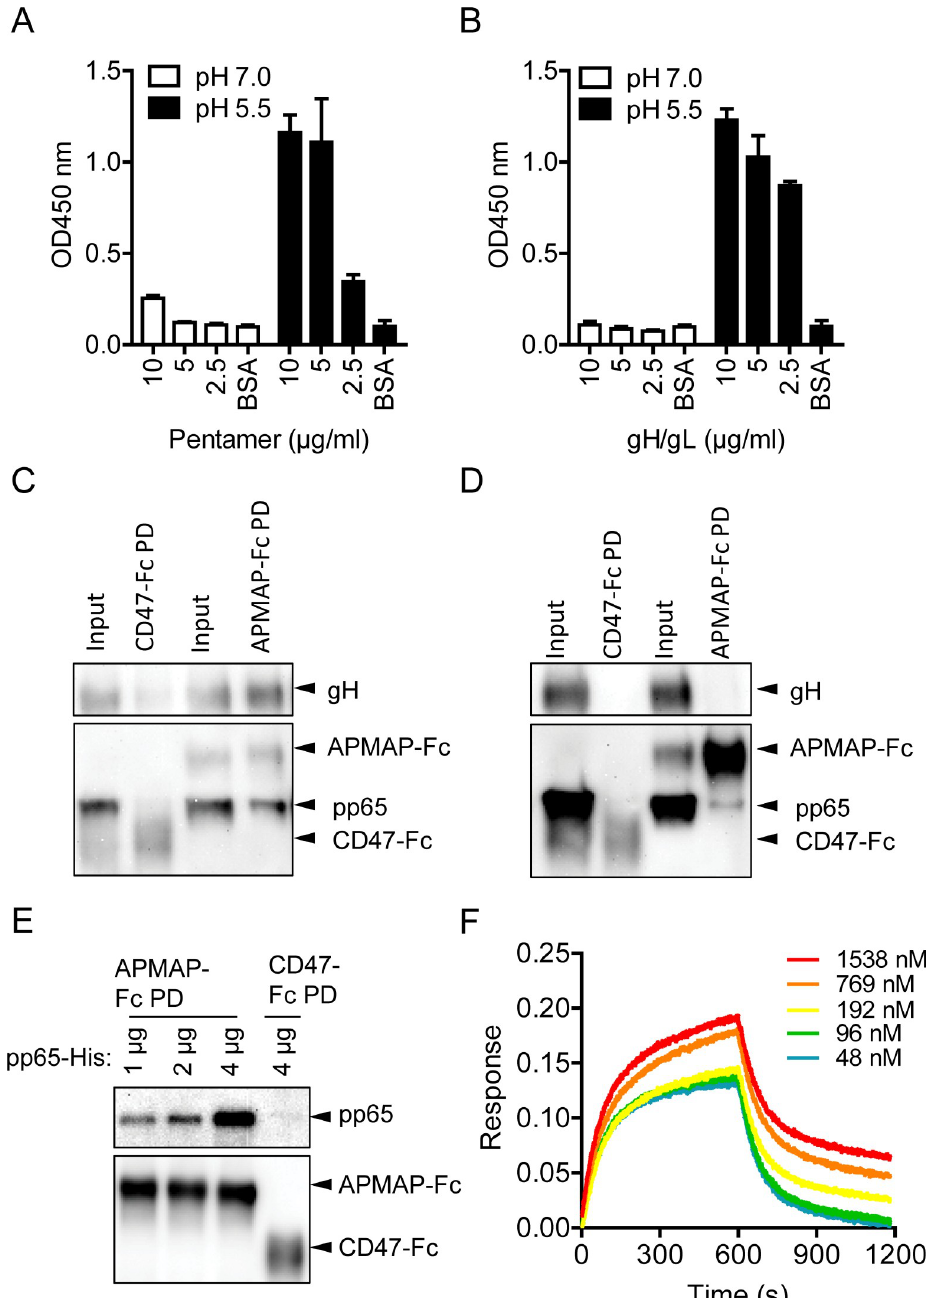
Fig 6. Interactions of APMAP with HCMV proteins. ( A-B ) The interaction of ( A ) Pentamer or ( B ) gH/gL dimer to APMAP at indicated concentrations in neutral pH 7.0 or acid pH 5.5 buffer was evaluated by ELISA assay. APMAP-Fc served as coating antigen. Pentamer was detected with HRP conjugated anti-His-tag antibodies which recognizes gH subunit of the pentamer. Samples with OD450nm readings that are 1.5 times higher than that of BSA control were considered positive. The data shown are representative results of two independent experiments. The bars represent means ± SD of replicate wells. ( C-D ) 1 μ g APMAP-Fc or control CD47-Fc protein was incubated with 2.58 × 10 6 PFU of AD169rev ( C ) in 500 μ l PBS or ( D ) 500 μ l RIPA buffer for 2 h at 4˚C. The protein complex was pulled down by Protein G beads and analyzed by western blot assay using anti-gH mAb, anti-pp65 mAb and HRP conjugated anti-mouse IgG antibodies. ( E ) 2 μ g APMAP-Fc or control CD47-Fc protein was loaded onto Protein G beads and then incubated with different amounts of His-tagged pp65 protein at room temperature for 1 h. After washing away of unbound protein, the beads were suspended into SDS containing loading buffer for western blot assay using mouse anti-His-tag mAb